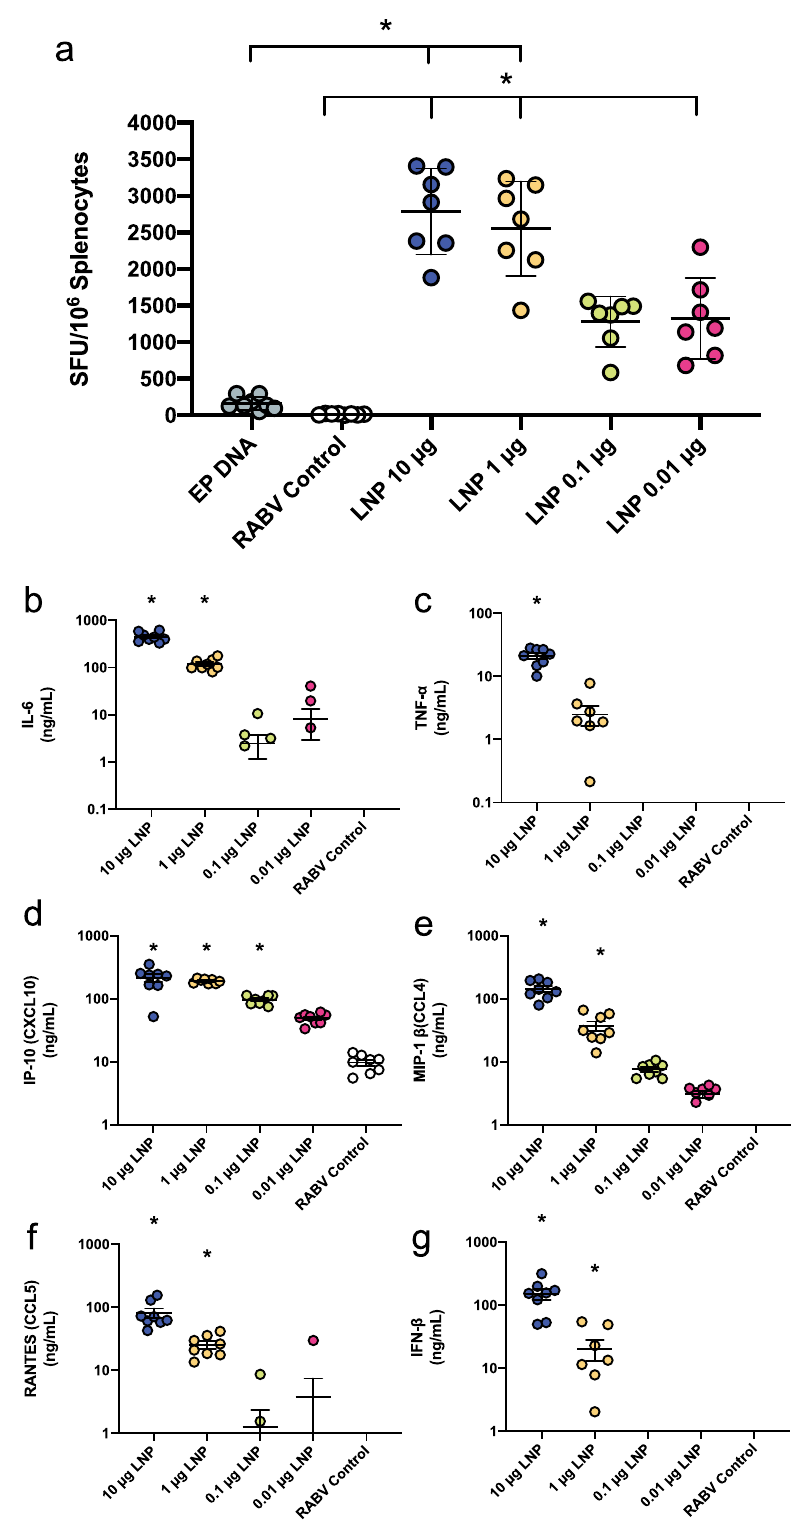
Fig. 3 Cellular and secreted cytokine responses to a SARS-CoV-2 saRNA LNP vaccine. a Quanti fi cation of IFN- γ splenocytes upon restimulation with SARS-CoV-2 peptides, expressed as spot forming units (SFU) per 10 6 cells with n = 7 biologically independent animals. Electroporated pDNA (EP pDNA) was used as a positive control while saRNA encoding the rabies glycoprotein (RABV) in pABOL was used as a negative control (RABV control). b – g Cytokine pro fi le in sera of mice 4 h after vaccination with SARS-CoV-2 LNP vaccine with n = 7 biologically independent animals. Remaining cytokines can be found in Supplementary Fig. 5. The asterisk (*) indicates signi fi cance of p < 0.05 as determined by a Kruskal – Wallis test. Line and error bars indicated mean ±